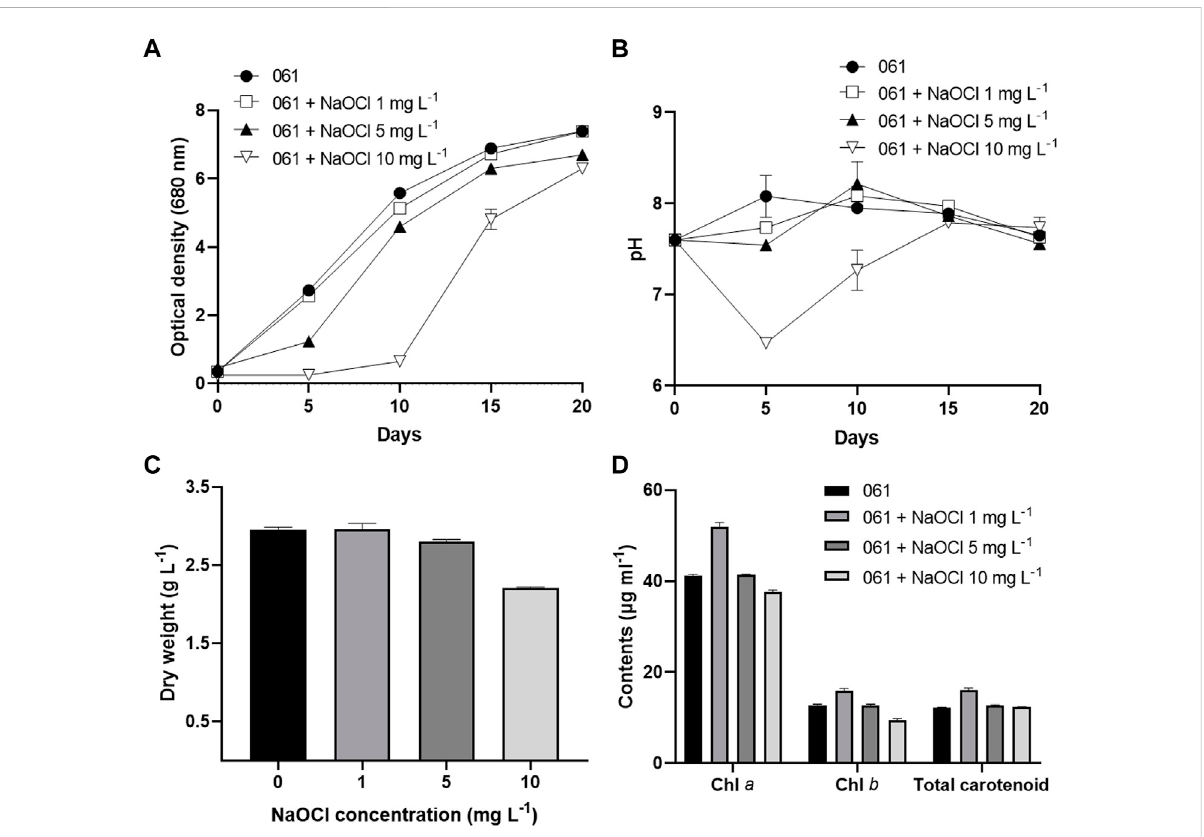
FIGURE 1 Growth characteristics of T. obliquus KNUA061 under different NaOCl concentrations. OD (A) and pH (B) of T. obliquus KNUA061 during the 20 days of cultivation. DW (C) and chlorophyll and total carotenoid contents (D) of microalgal biomass after 20 days of